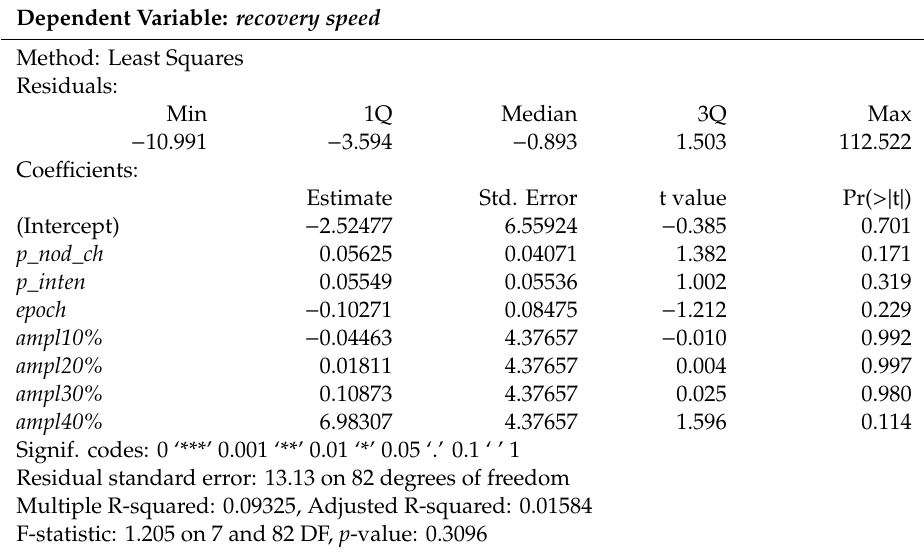
Table 6. Regression model for recovery speed , instance fl3795.